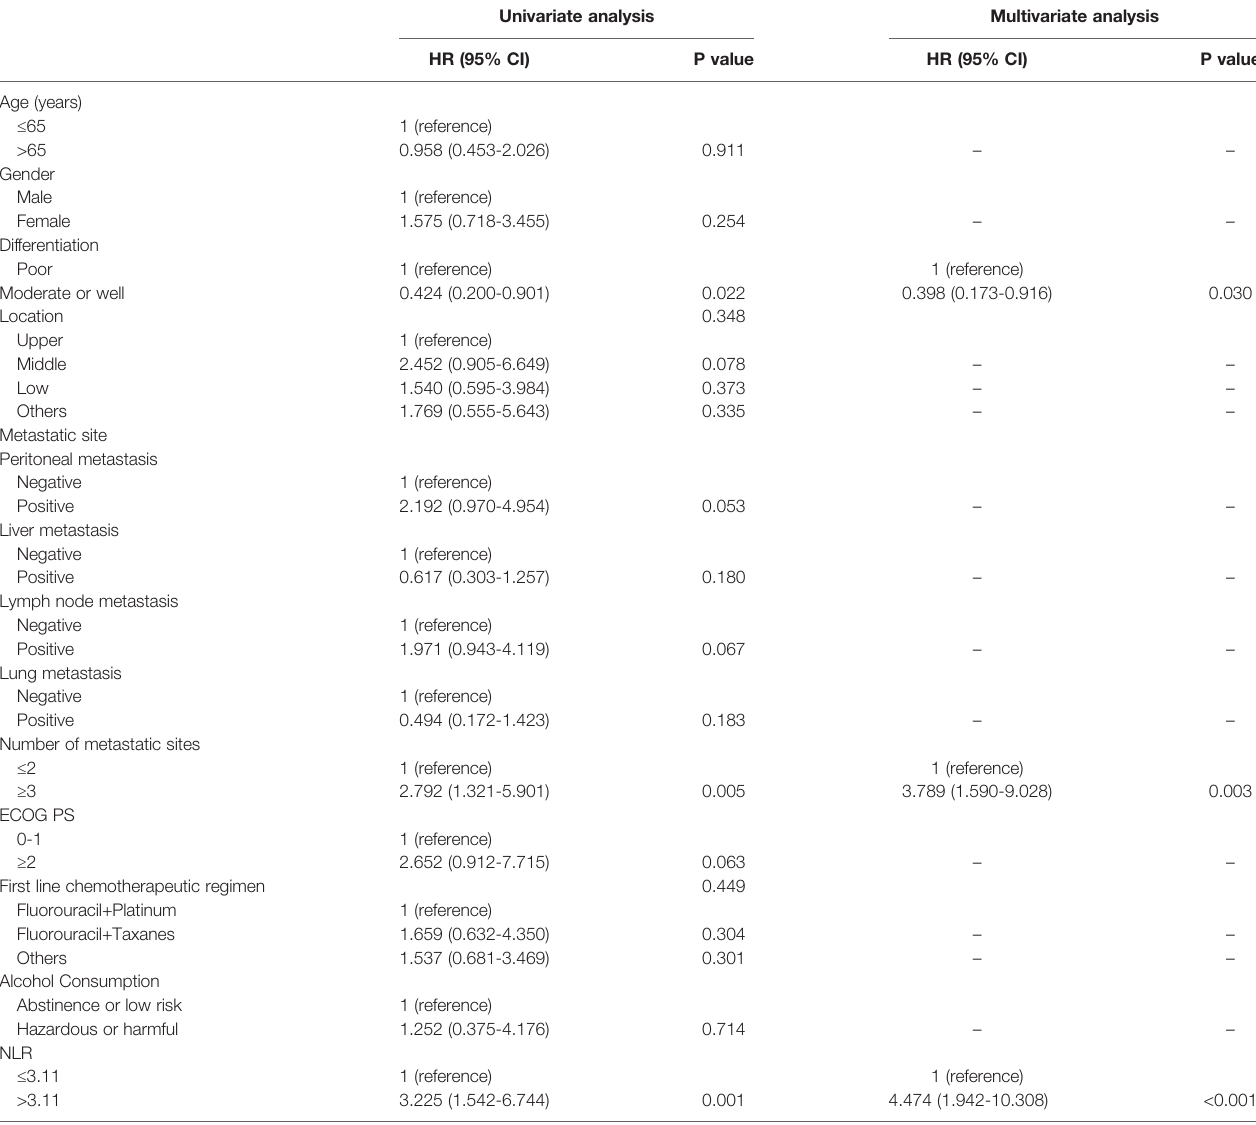
TABLE 5 | Univariate and multivariate analysis of factors according to OS in AGC patients treated with anti-PD-1 drugs in the second-line or posterior